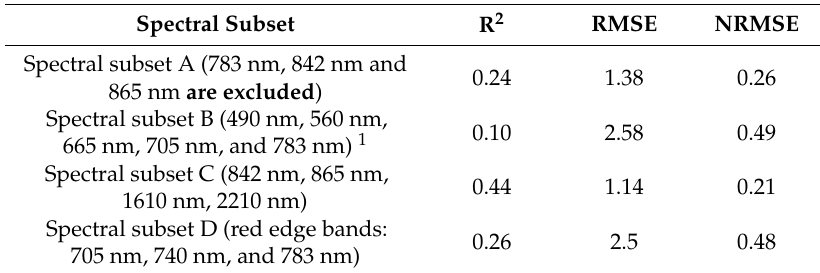
Table 4. R 2 , RMSE, and NRMSE (m 2 /m 2 ) between measured and retrieved LAI based on selected spectral subsets from Sentinel-2 (n =